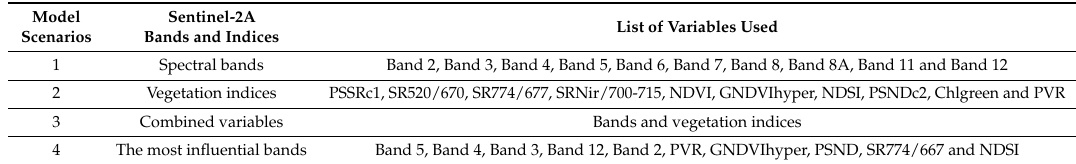
Table 3. Bands and indices from Sentinel-2A MSI data used as independent variables for predicting the probability of occurrence of the C. tristis with Maxent